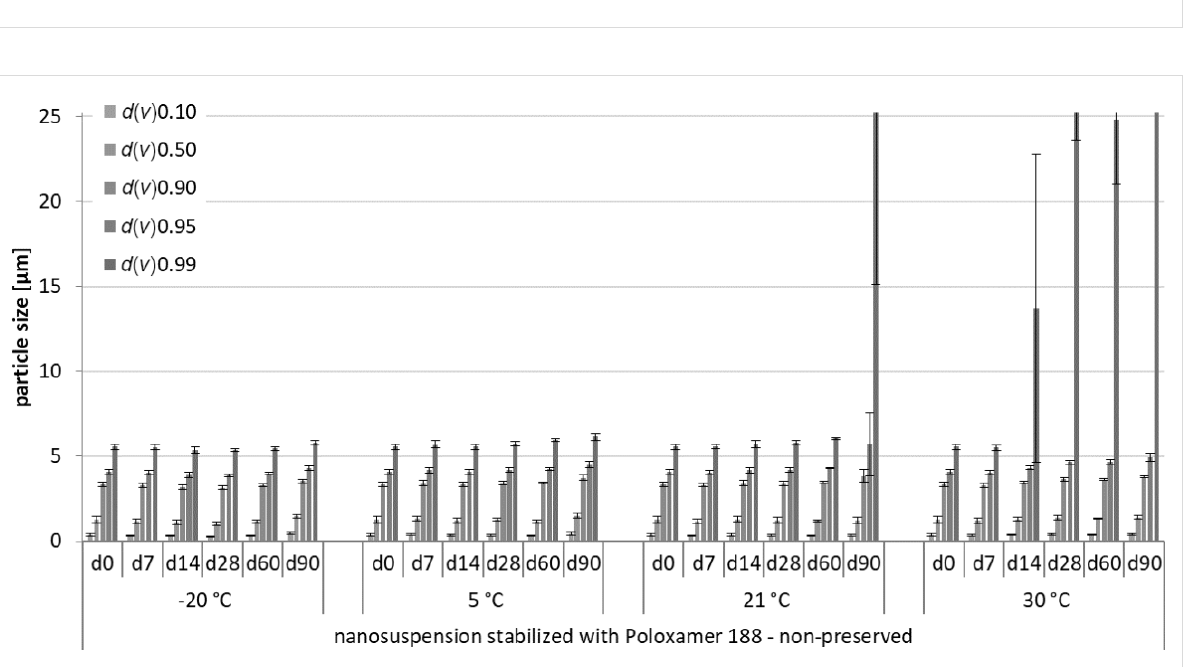
Figure 2: Physical stability during three months of storage at different storage temperatures for the non-preserved nanosuspensions stabilized with Poloxamer 188 (LD data).